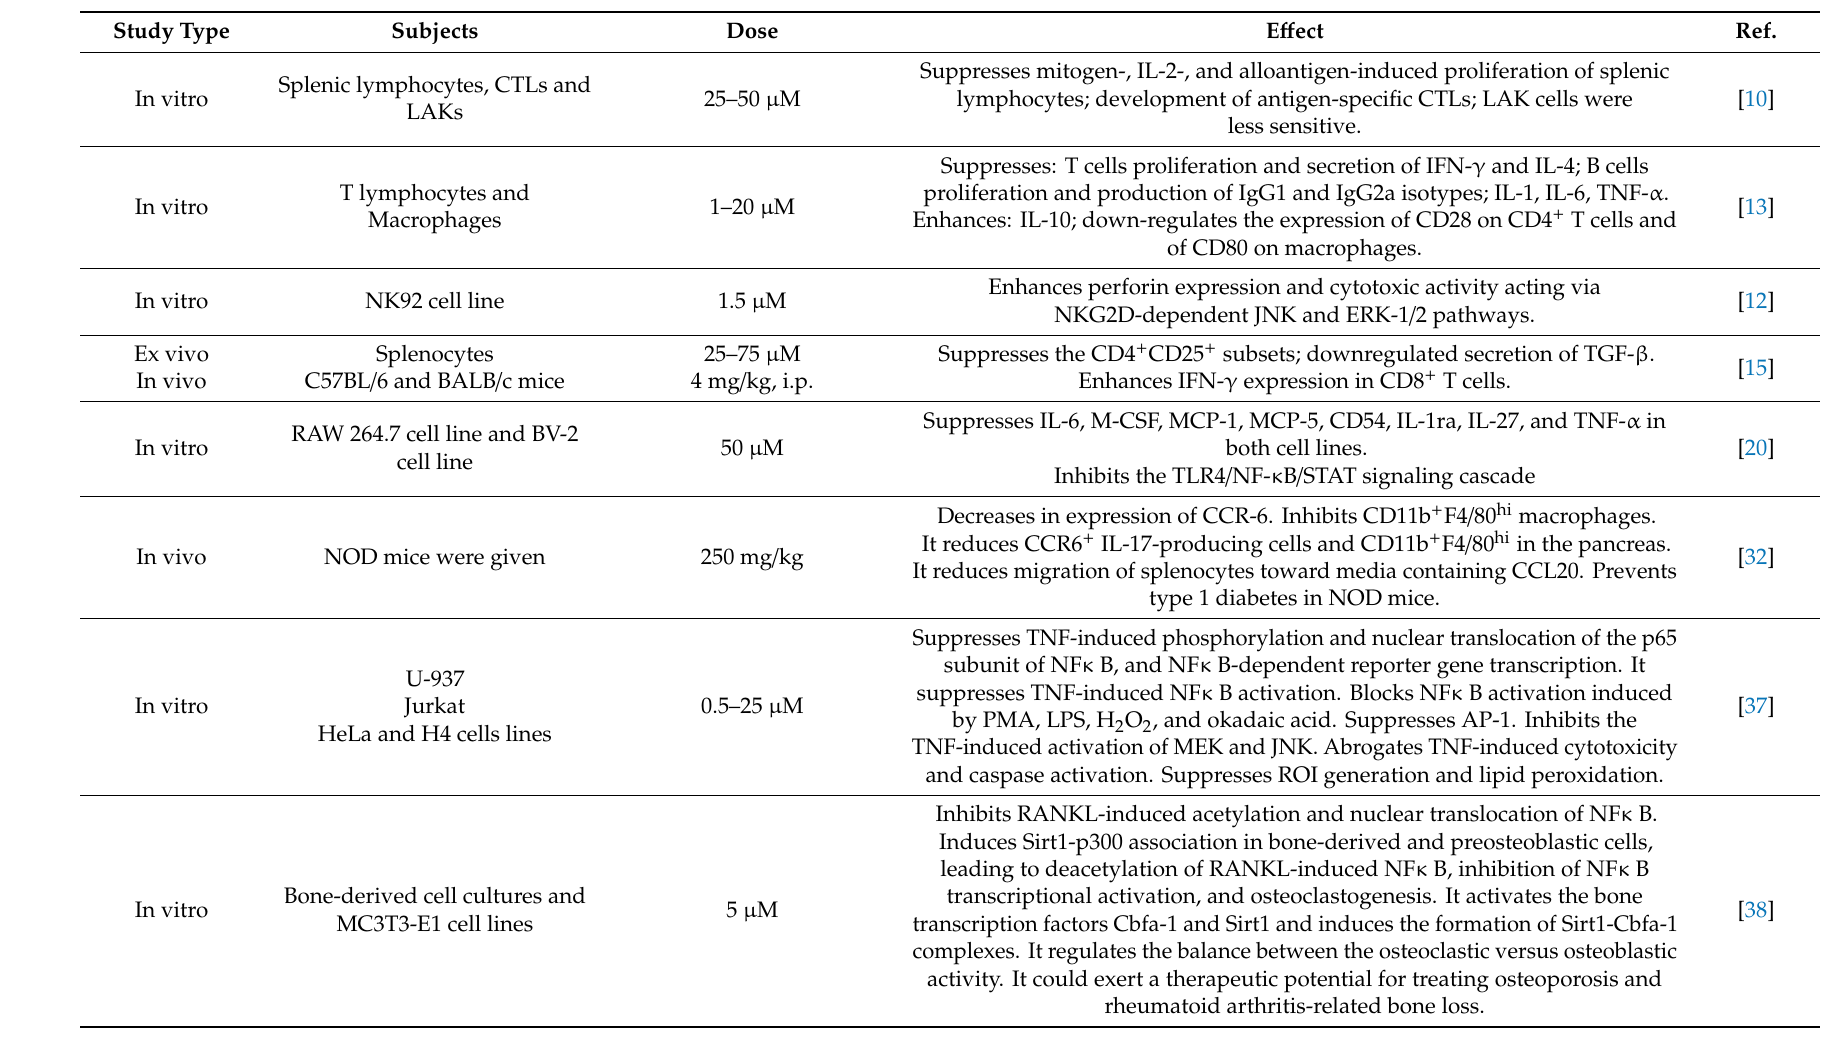
Table 1. Activity and e ff ects of resveratrol in immune cells and in mice